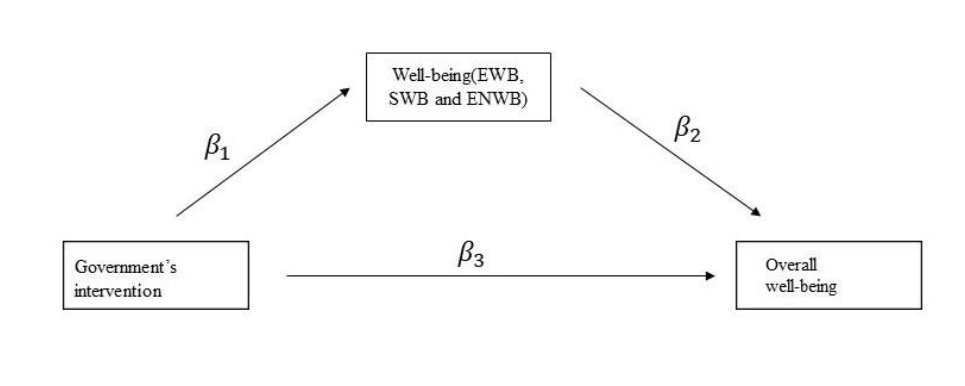
Figure 1: The path diagram of mediation